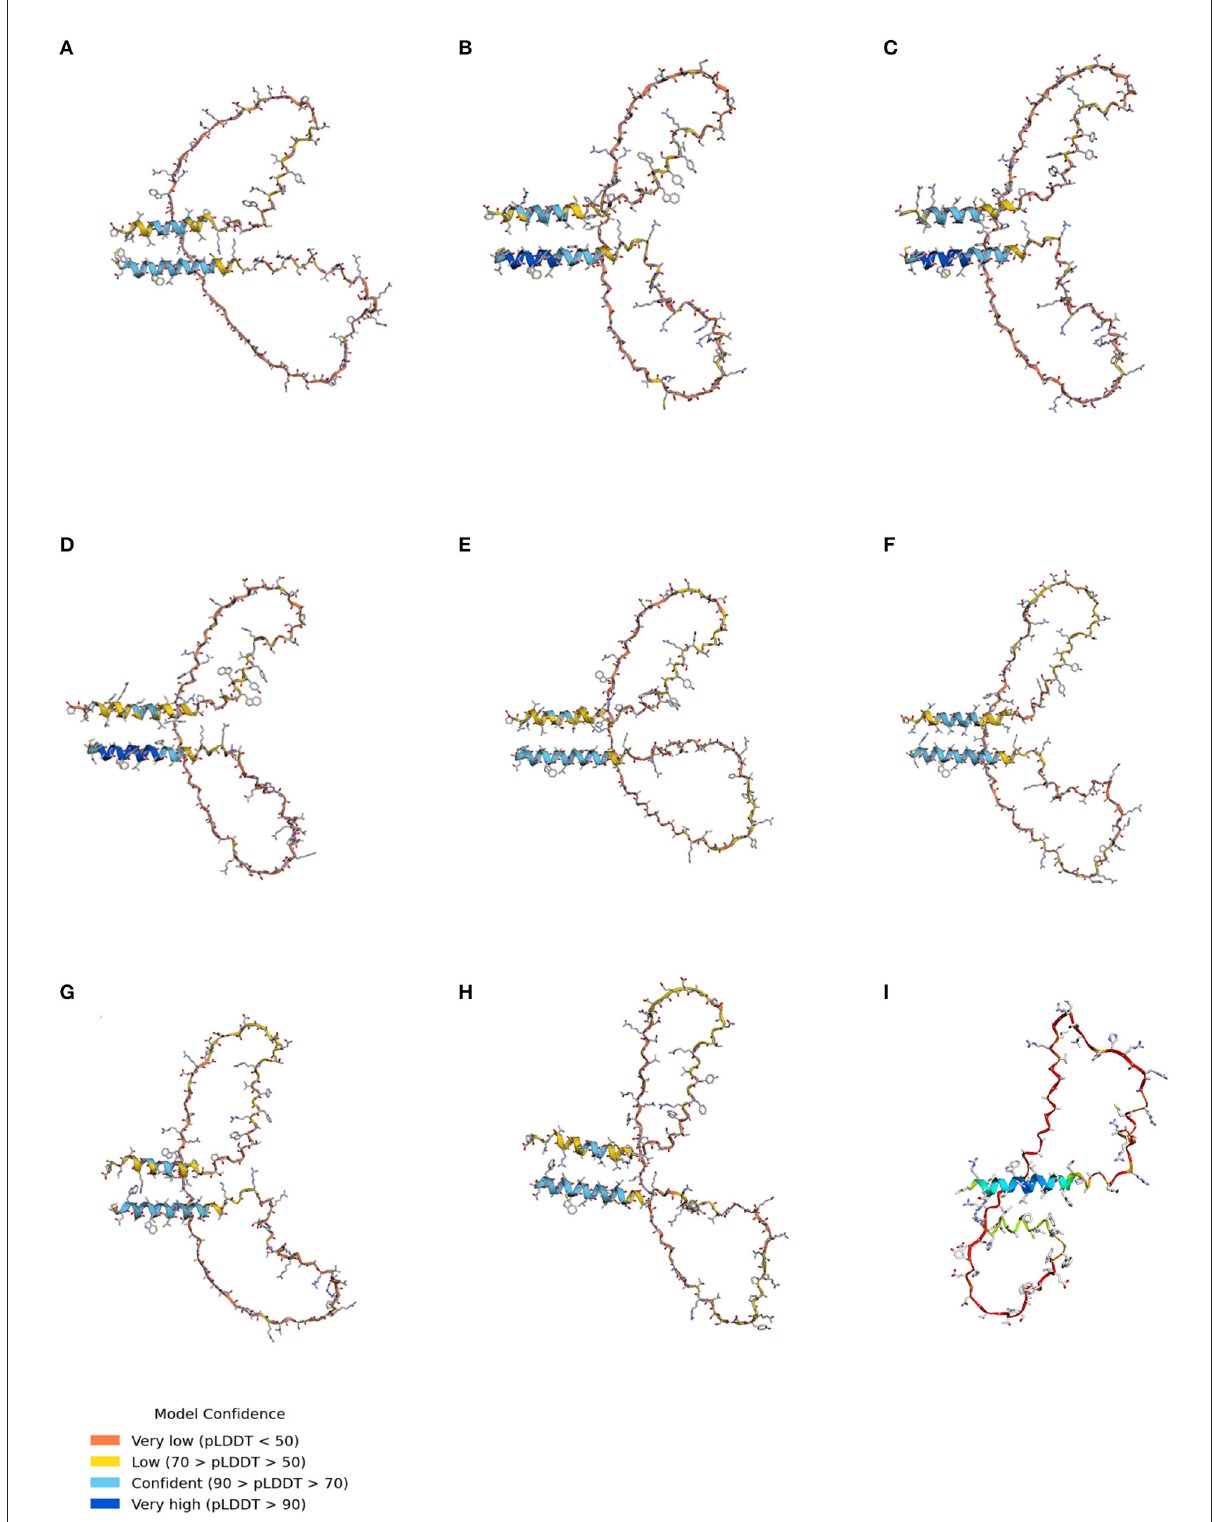
FIGURE4 The tertiary structure of Sho. (A) The tertiary structure of the human Sho. (B) The tertiary structure of bovine Sho. (C) The tertiary structure of ovine Sho. (D) The tertiary structure of caprine Sho. (E) The tertiary structure of red deer Sho. (F) The tertiary structure of equine Sho. (G) The tertiary structure of canine Sho with the wild-type allele. (H) The tertiary structure of canine Sho with the 70_71DelAA allele. (I) The tertiary structure of chicken Sho. pLDDT, predicted local distance difference